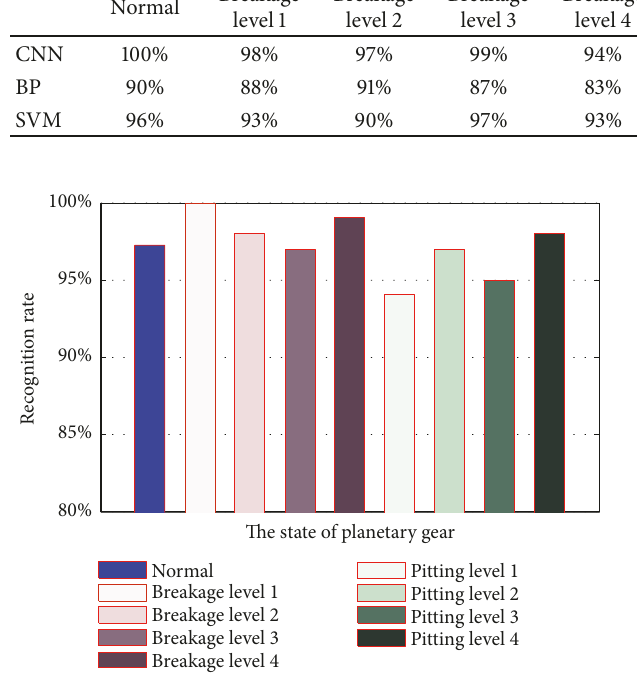
Figure 9: The recognition result of CNN for testing samples.